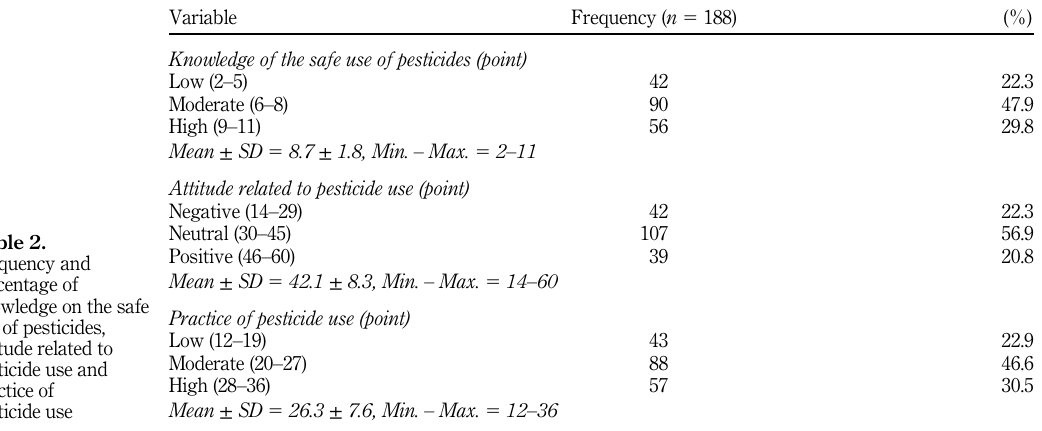
Table 2. Frequency and percentage of knowledge on the safe use of pesticides, attitude related to pesticide use and practice of pesticide